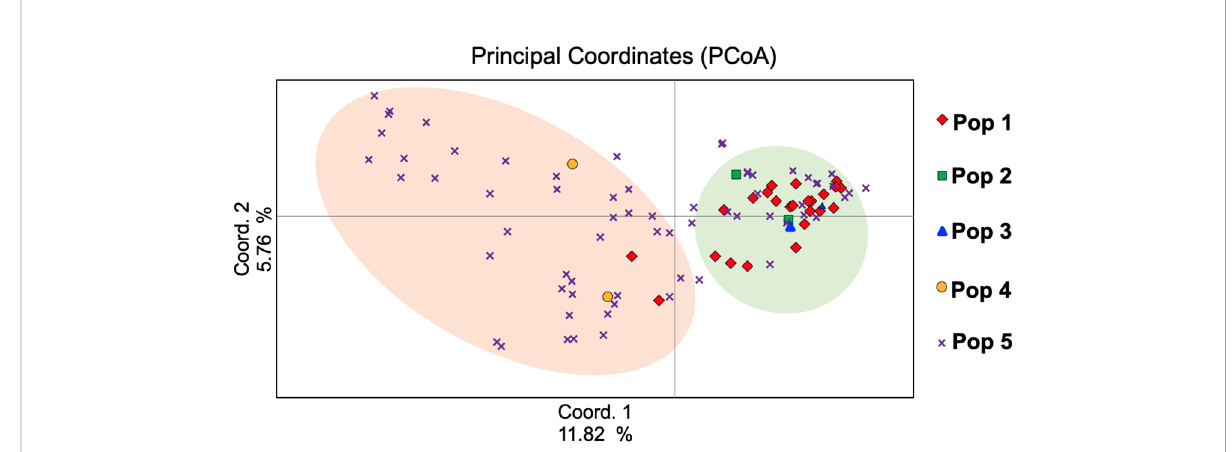
FIGURE 4 Principal coordinate analysis (PCoA) of the Western Canadian barley genotypes.